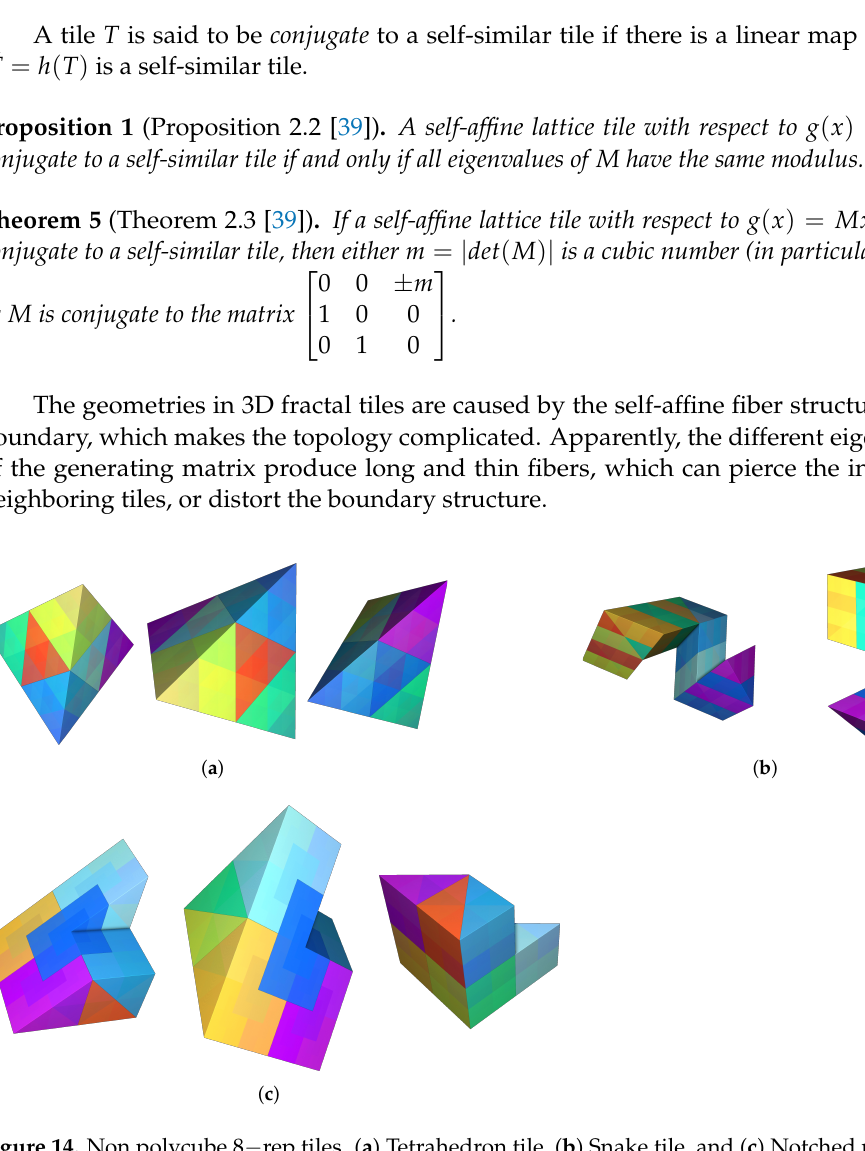
Figure 14. Non polycube 8 − rep tiles. ( a ) Tetrahedron tile, ( b ) Snake tile, and ( c ) Notched prism